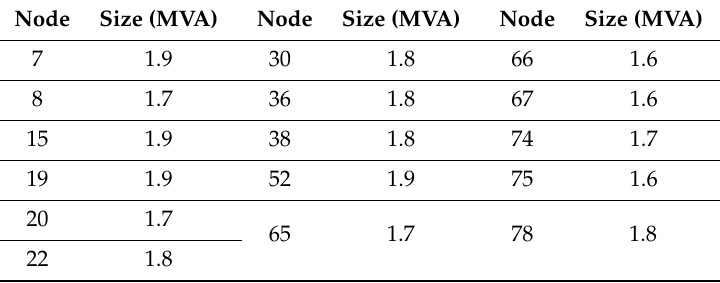
Table 7. DGs for 83-node distribution